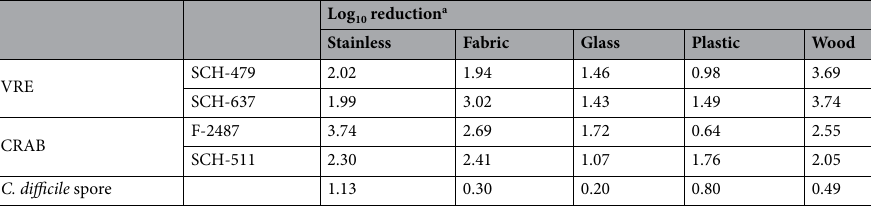
Table 2. Effects of zone on bacterial kill of VRE, CRAB and C. difficile on various materials. VRE vancomycin- resistant enterococci , MRAB multidrug-resistant Acinetobacter Baumanii, a numbers of colony-forming units per milliliter of test organisms.